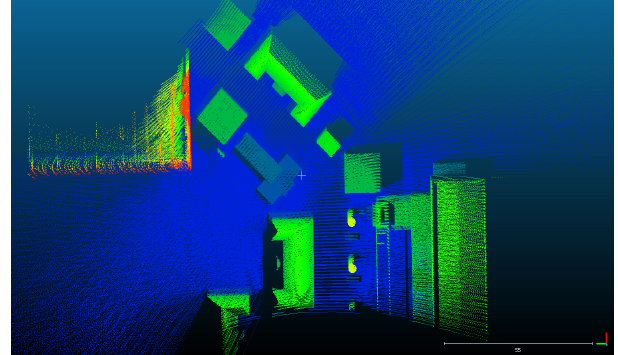
Figure 9. Map produced by georeferencing the LiDAR data of the fixed Velodyne